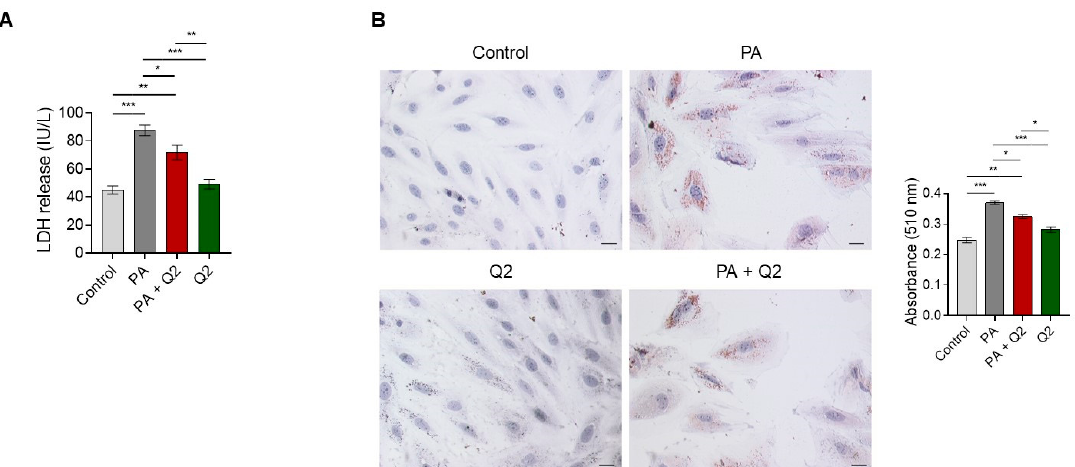
Figure 6. Effects of Q2 on PA-induced cytotoxicity and lipid accumulation in H9c2 cardiomyocytes. ( A ) Lactate dehydrogenase (LDH) release in the culture medium of H9c2 cardiomyocytes treated with vehicle (control), PA (200 µM), Q2 (250 nM) for 2 h and PA for additional 24 h, and Q2 alone (250 nM) for 24 h. LDH activity was expressed as IU/L and data represent the mean ± SEM of six separate experiments. Significant differences were detected by one-way ANOVA and Newman–Keuls multiple comparison test, p < 0.05 (*); p < 0.01 (**); and p < 0.001 (***). ( B ) Representative images of Oil Red O staining for intracellular lipid droplets assessment in H9c2 cardiomyocytes treated with vehicle (control), PA (200 µM), Q2 (250 nM) for 2 h and then PA for 24 h, and Q2 alone (250 nM) for 24 h. Quantification of the lipid droplets was performed by measuring the absorbance at 510 nm. Values are the mean ± SEM of three different experiments. Significant differences were detected by one-way ANOVA and Newman–Keuls multiple comparison test, p < 0.05 (*); p < 0.01 (**); and p < 0.001 (***). Scale bar : 25 µm.